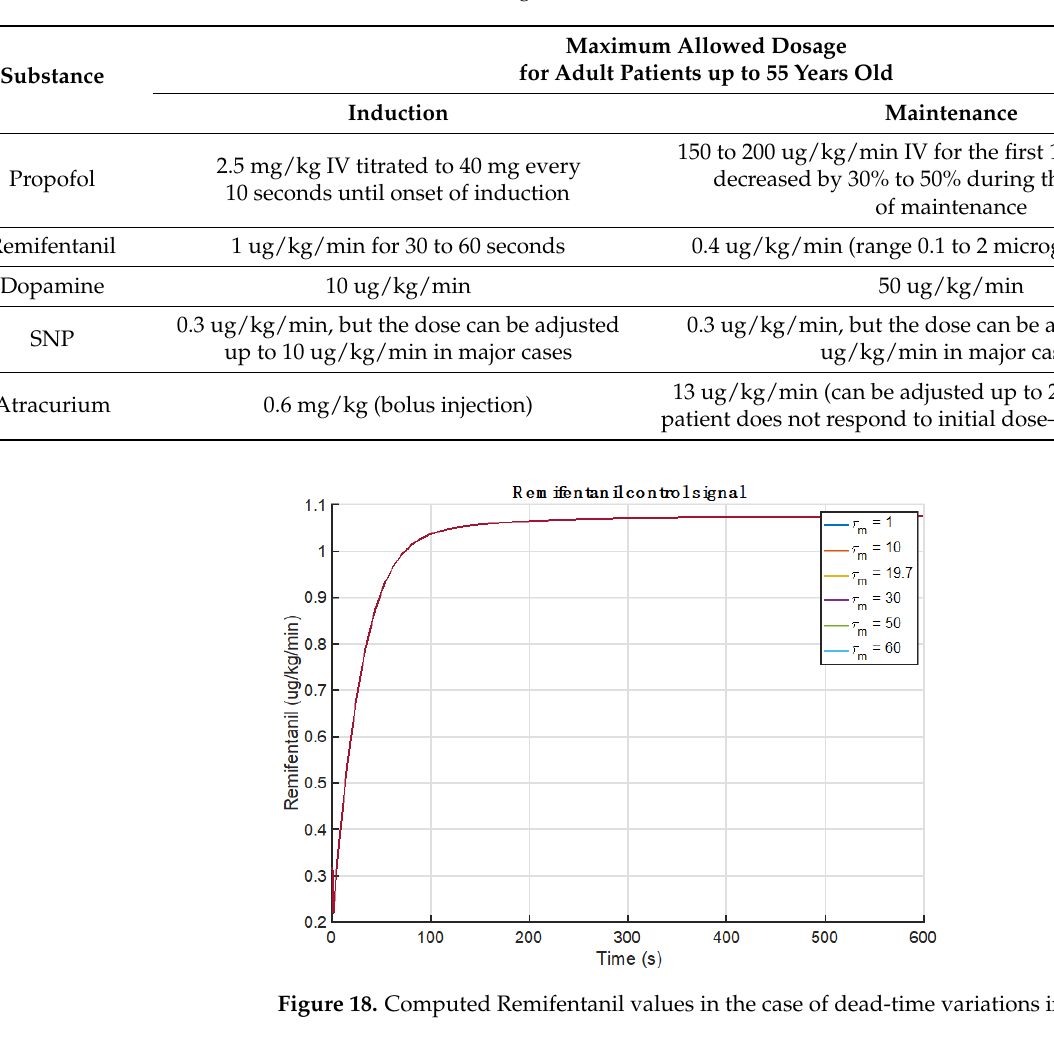
Table 7. Maximum dosage of anesthetic substances.